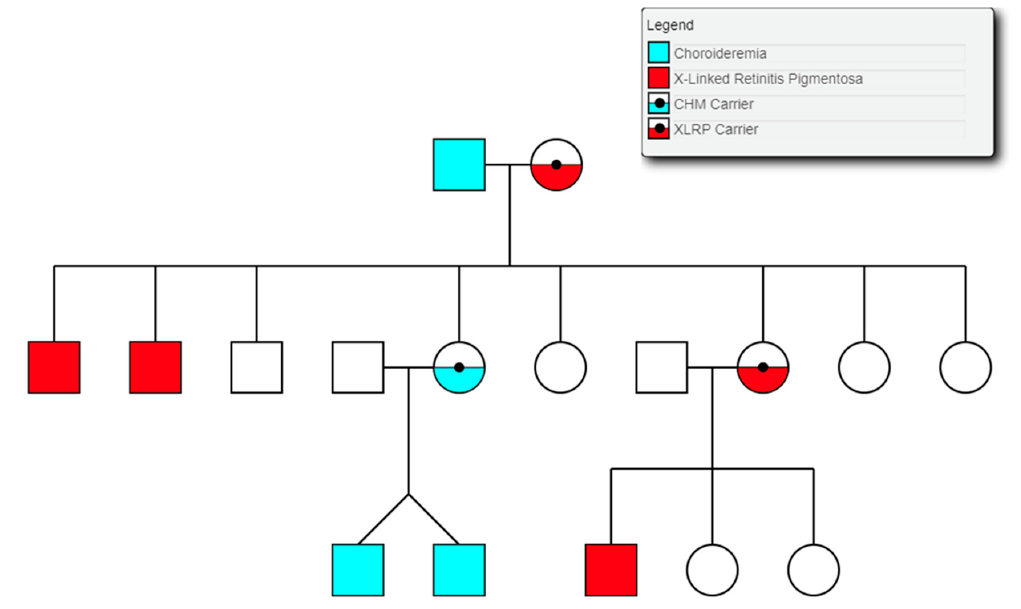
Figure 12. Partial pedigree tree illustrating the segregation of two X-linked retinal conditions within one family.